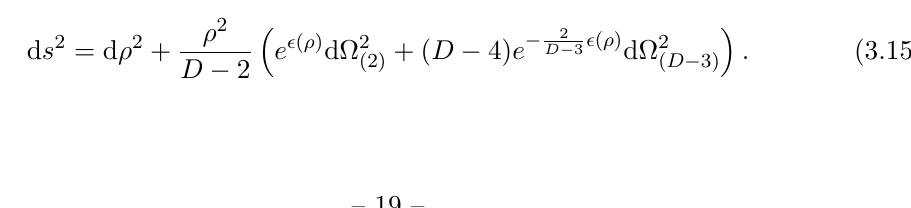
Figure 7 . Euclidean time radius and axis radius as a function of the dimensionless inverse tem- perature. At the horizon points along the axis, i.e. at the extremes of the S 1 S 1 has zero size. Then the (cid:12)bration of one circle on the other gives a topological S 2 . According to (cid:12) this (cid:12)gure, as we approach the merger with the non-uniform branch, R (cid:28) (cid:24) R axis =L : the 2-sphere is